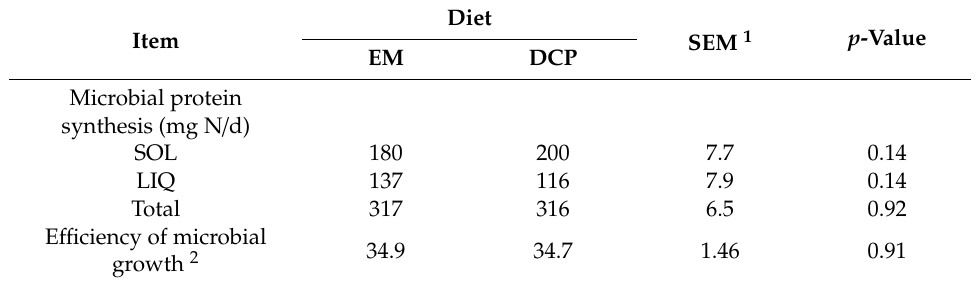
Table 4. E ff ects of replacing extruded maize (EM) by dried citrus pulp (DCP) in the diet on microbial protein synthesis in solid (SOL) and liquid (LIQ) phases and its e ffi ciency in Rusitec fermenters (n = 4).